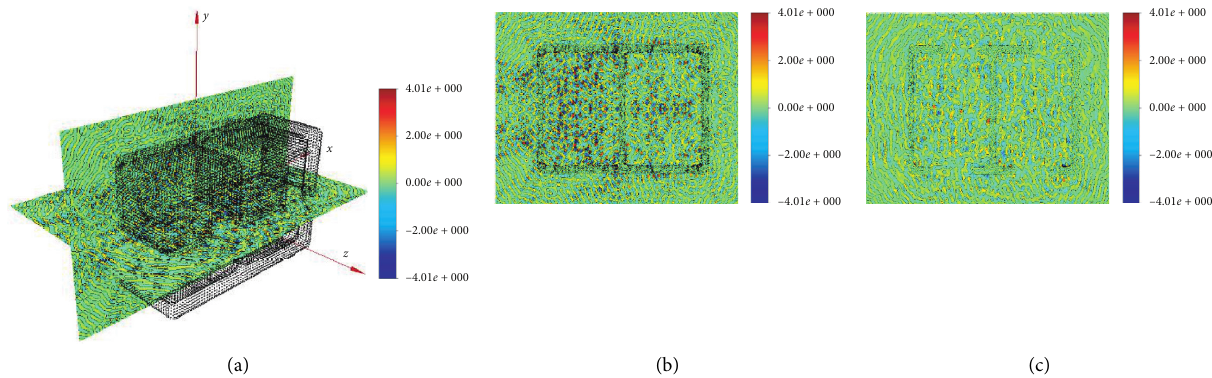
Figure 7: The isometric (a), x - y plane (b), and x - z plane (c) view of the rooms for 3600MHz.